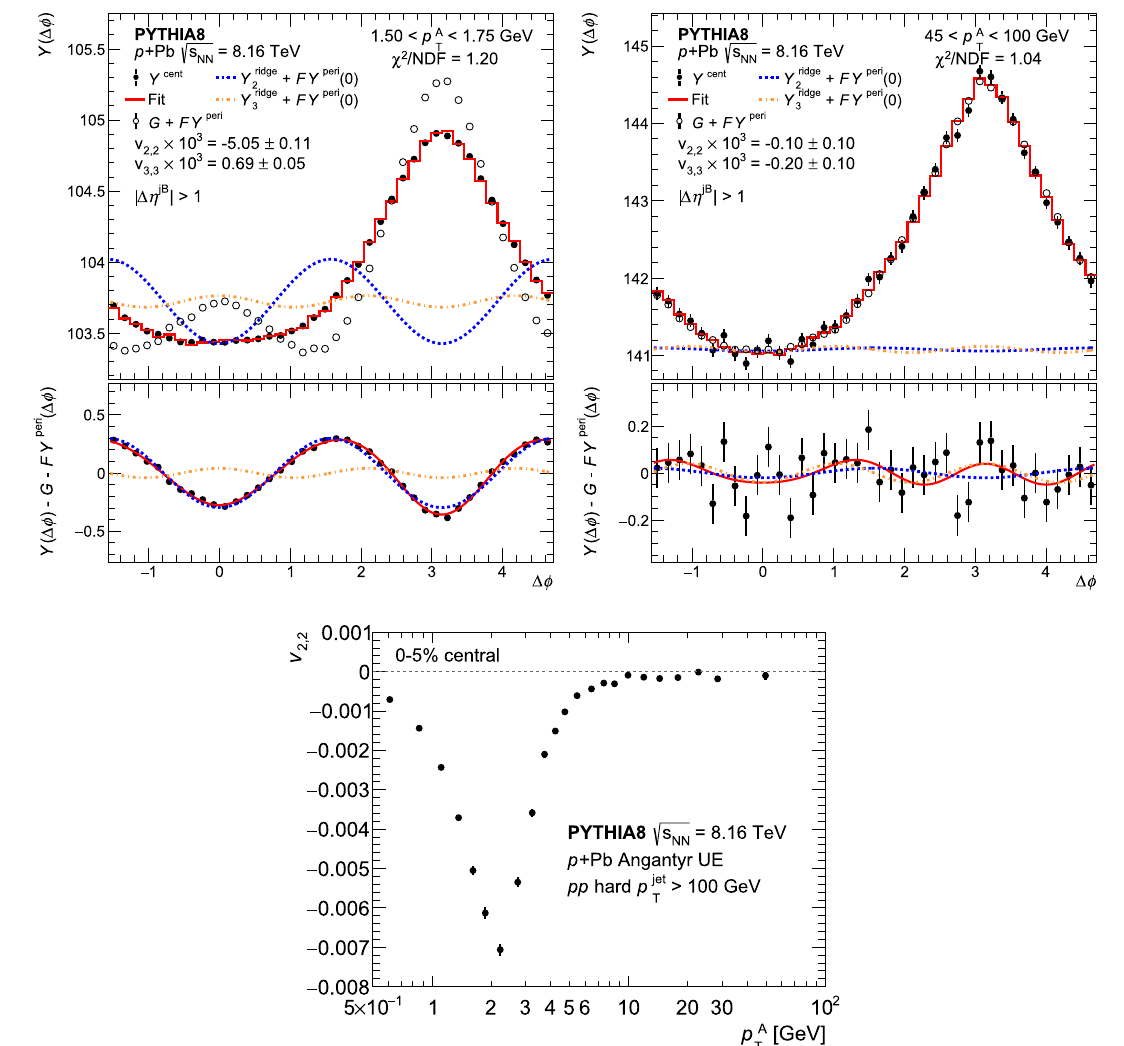
Fig. 8 Predictions of azimuthal anisotropy from Pythia 8 using the same two-particle formalism used for the data results. The events com- bine minimum-bias p +Pb underlying events generated in the Angantyr framework with hard pp events that require the presence of a jet with p T > 100 GeV. The two top plots show example correlation functions, with template fits, from a low particle- p T selection (top left) and a high particle- p T selection (top right). In the upper panels of the two top plots, the open circles show the scaled and shifted peripheral template with uncertainties omitted, the closed circles show the central data, and the red histogram shows the fit (template and harmonic functions). The